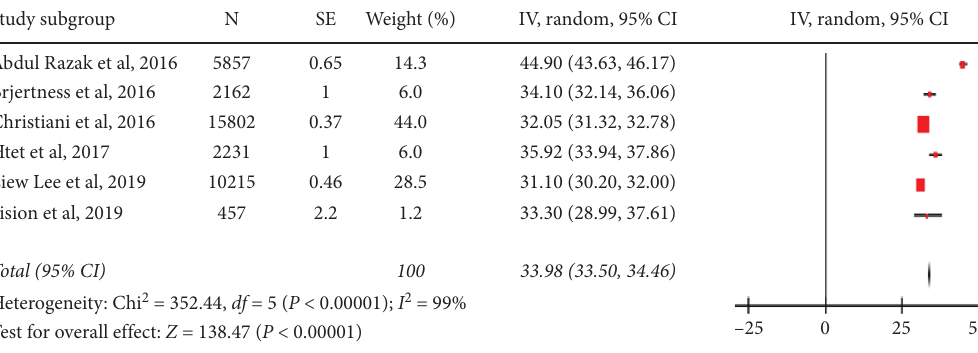
Figure 3: Forest plot of the studies among a community setting.